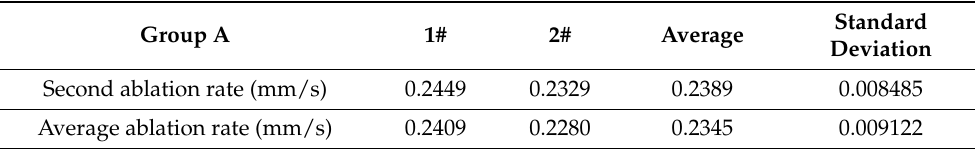
Table 7. Ablation rate of Group A in second ablation experiment and whole process (gas phase velocity was 2